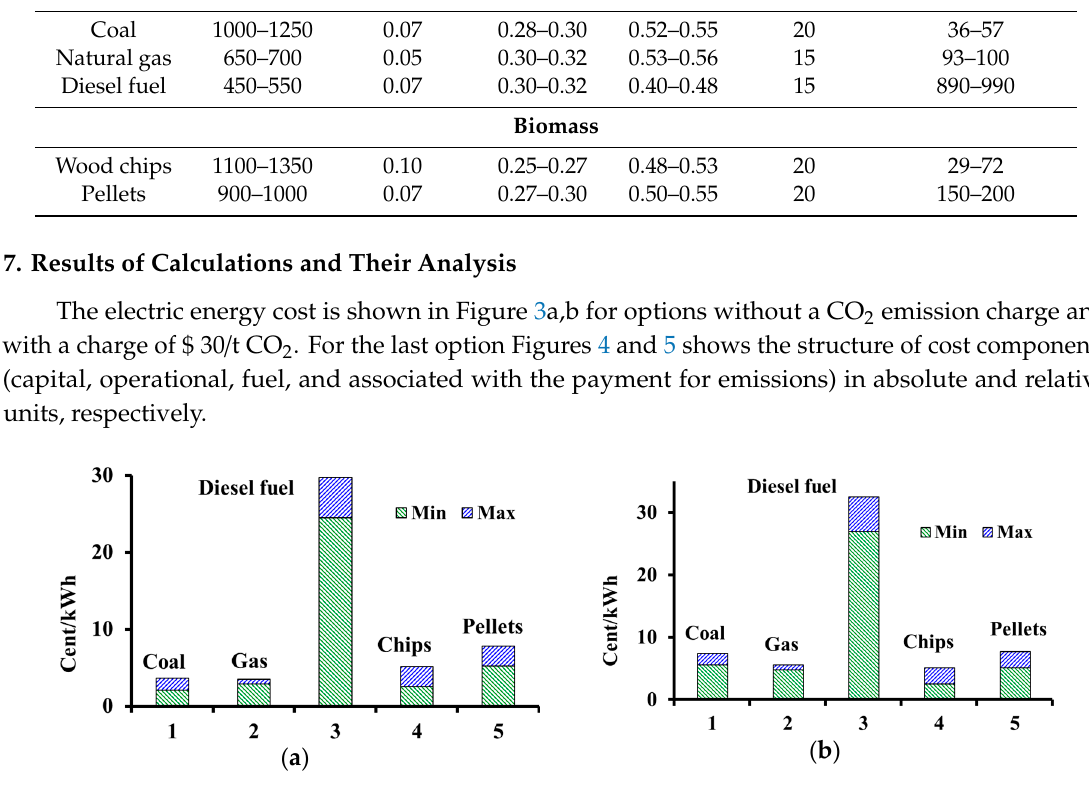
Figure 3. The cost of electric energy from energy sources using different types of fuel (( a )–without carbon tax, ( b )–with carbon tax, min and max–minimum and maximum energy cost taking into account the uncertainly interval).